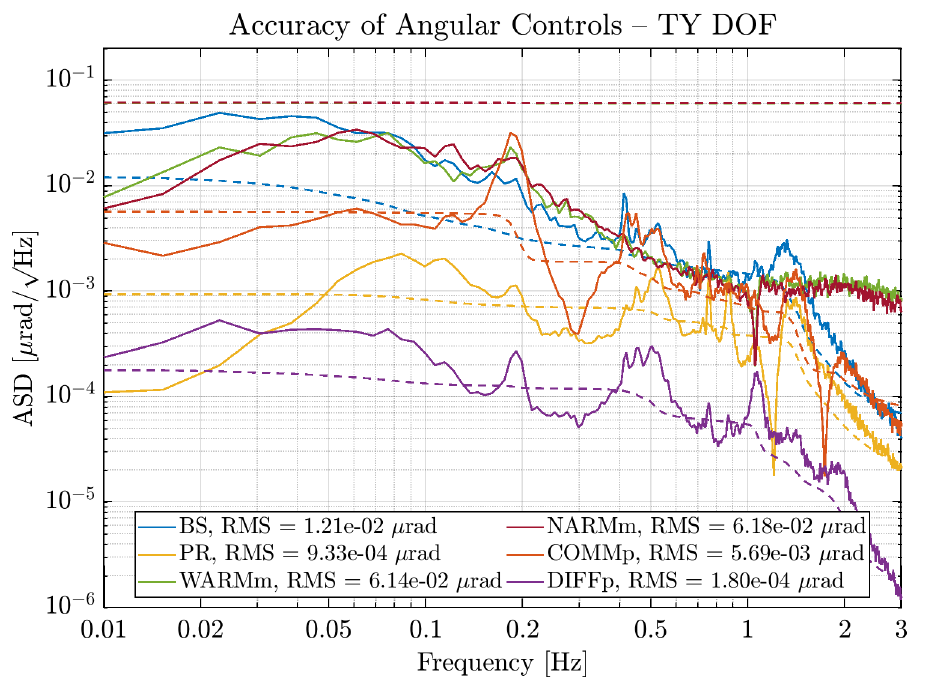
Figure 9. Amplitude Spectral Density (ASD) of the accuracy of Angular Controls in Phase III, θ y DOFs. ( − ) modes are defined in the single cavity basis (see text). Dashed lines are the RMS of the signal of the same